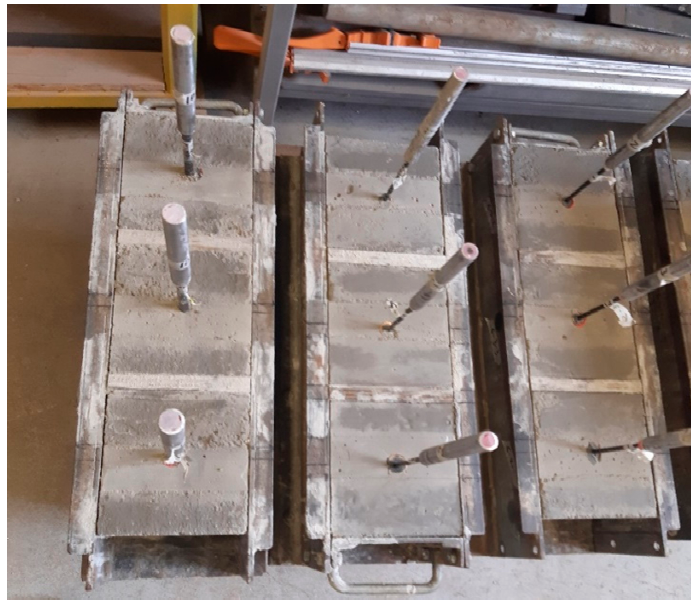
Figure 5 . Pull-out specimens filled with SCGC.